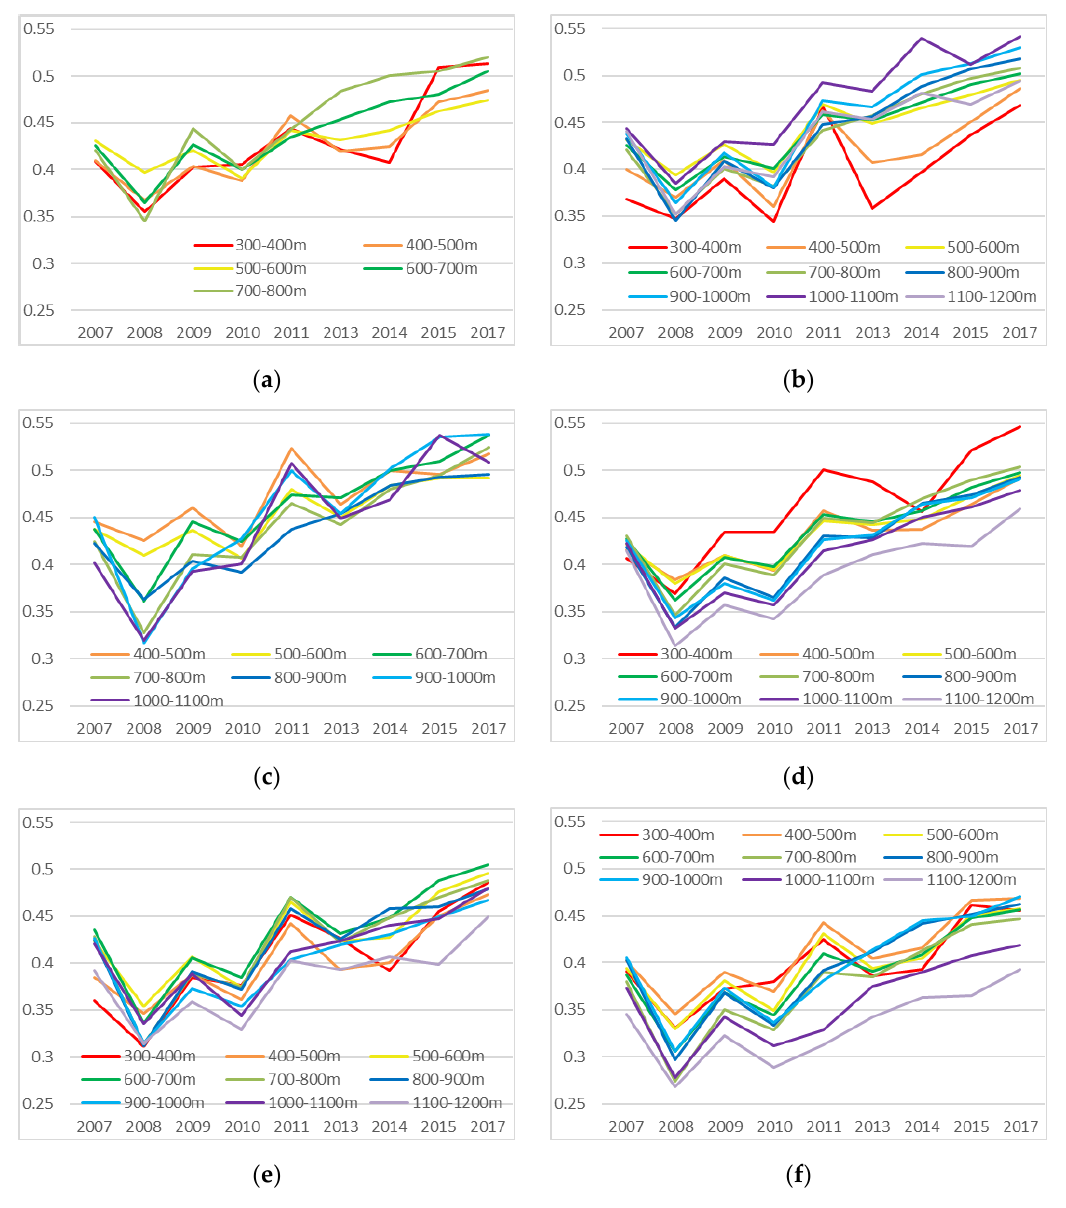
Figure 12. Broken-line graph showing EVI changes from 2007 to 2017, in all elevation zones, for six forest types: ( a ) CF; ( b ) PM; ( c ) CM; ( d ) CABM; ( e ) BM; and ( f ) OHB. Table 12. Disaster-impact-analysis results for six forest types in different elevation zones.